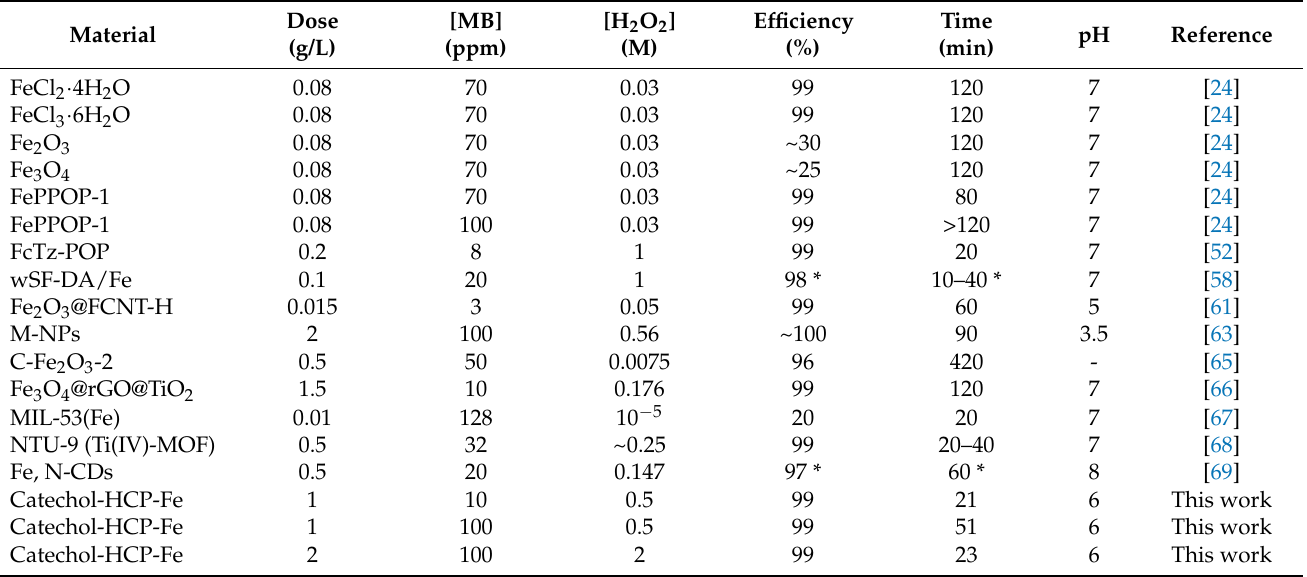
Table 3. MB degradation efficiency using different catalysts under visible